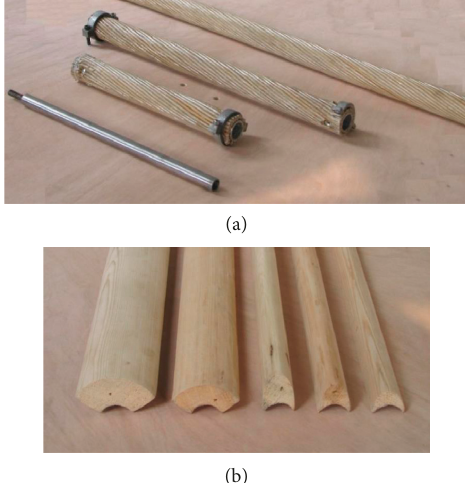
Figure 2: The test model of conductor: (a) conductor model and (b) ice